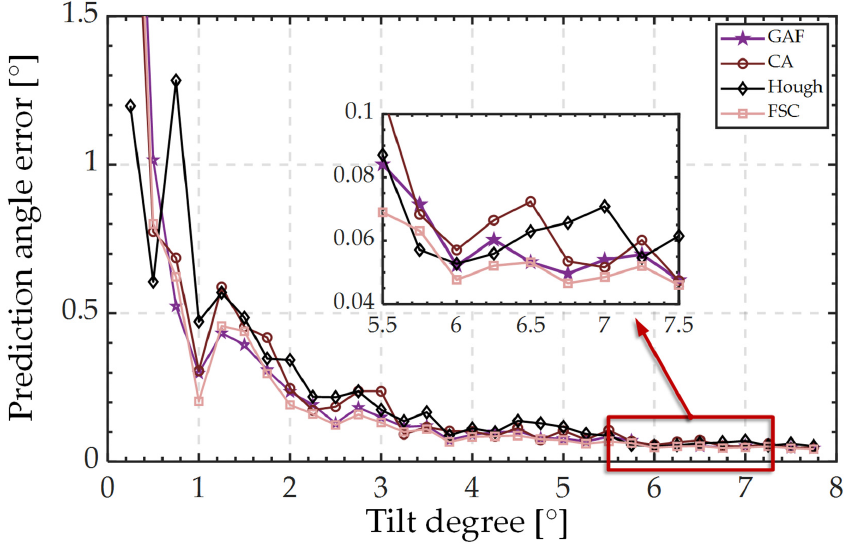
Figure 12. Variation in prediction error ϕ of different algorithms as a function of θ